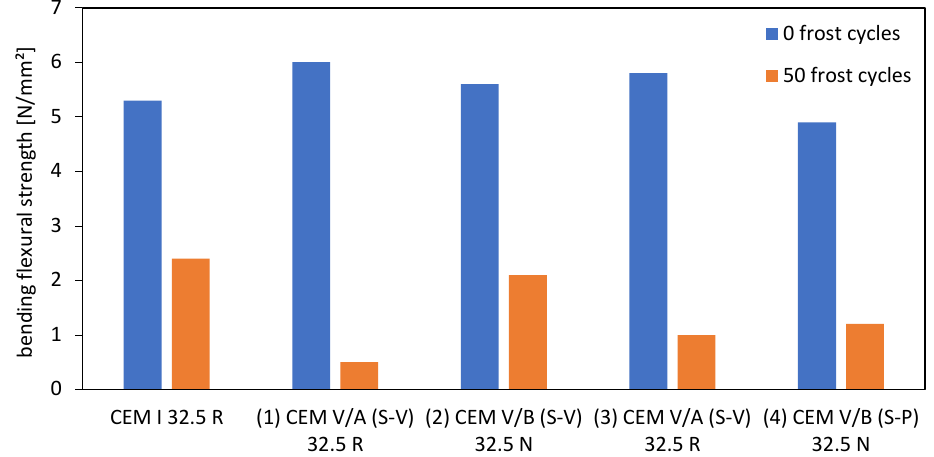
Figure 10. Bending flexural strength without and with frost impact evaluated after 90 days of water curing (each value as mean value of 3 individual tests).